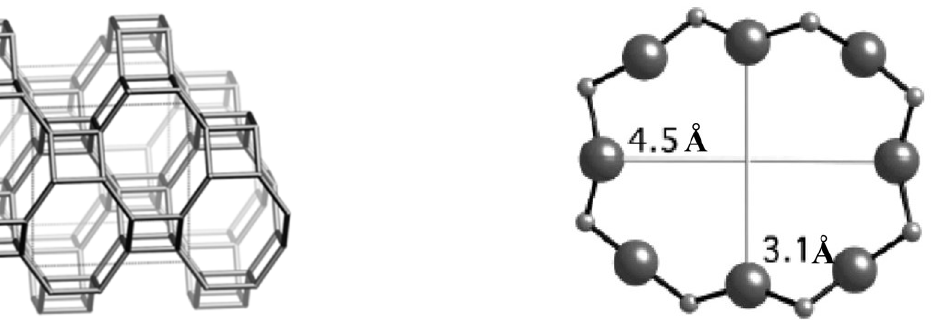
( right ). Source: Database of Zeolite Structure of the International Zeolite Association (IZA): https: